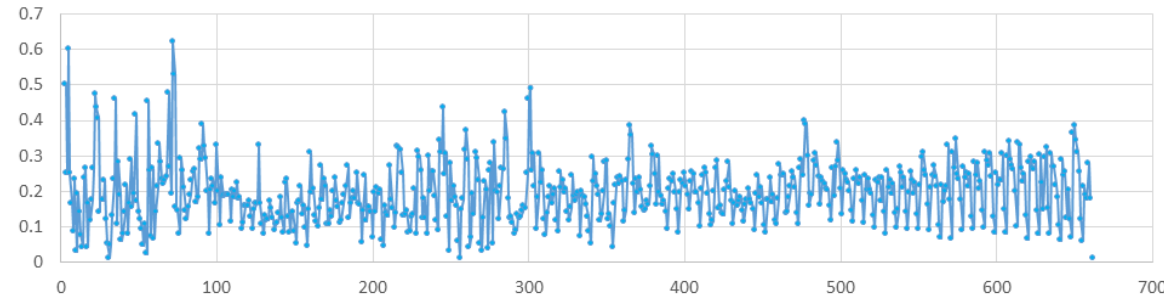
Figure 3. Daily calculated value of transmission rate. According to our calculations, in the first transmission rate training time frame, β (t) was normal distributed with a mean value of 0.170 and a standard deviation of 0.075 (Figure 4).